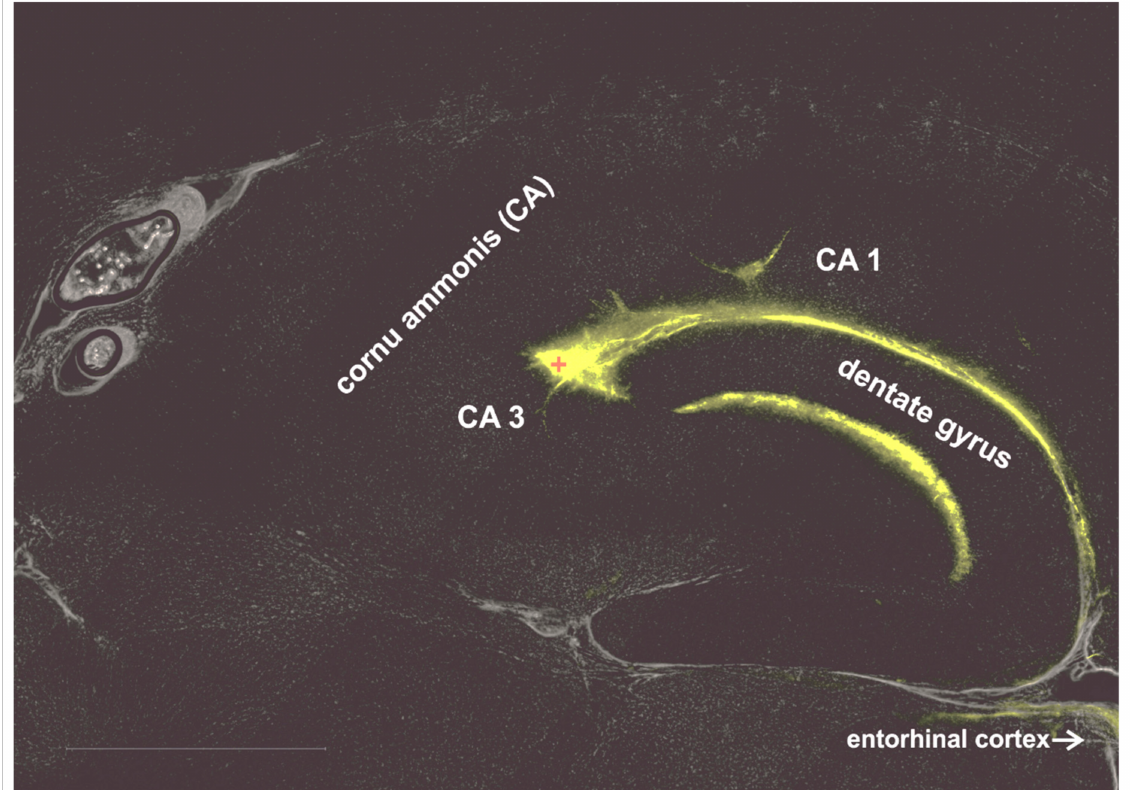
Figure 1. Marker dispersion in the hippocampus. The immunofluorescence image shows that the injected marker disperses from the injection site (CA3-region) into the CA1-region. (injection site denoted by the red + ). CA = Cornu